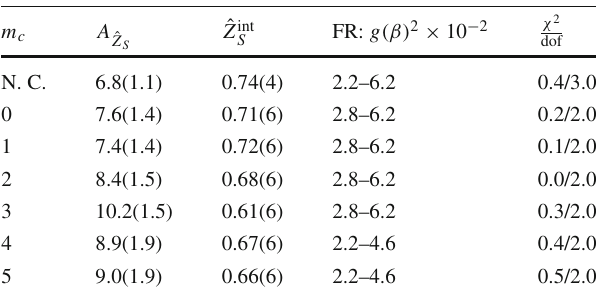
Fig. 12 The interpolations at the continuum limit of the numerical results of the renormalization constant ˆ Z S for the scalar density. The colored symbols and the colored lines indicate the numerical results and the fitting results, respectively. The small window in the figure shows the interpolated results of ˆ Z S Table10 Thefittingresultsoftheslope A ˆ andtheinterpolatedresults Z S ˆ Z int of the renormalization S